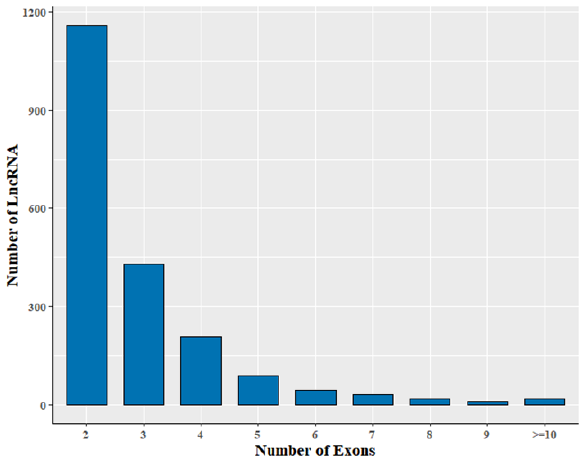
Figure 3. Statistics of number of lncRNA exons.